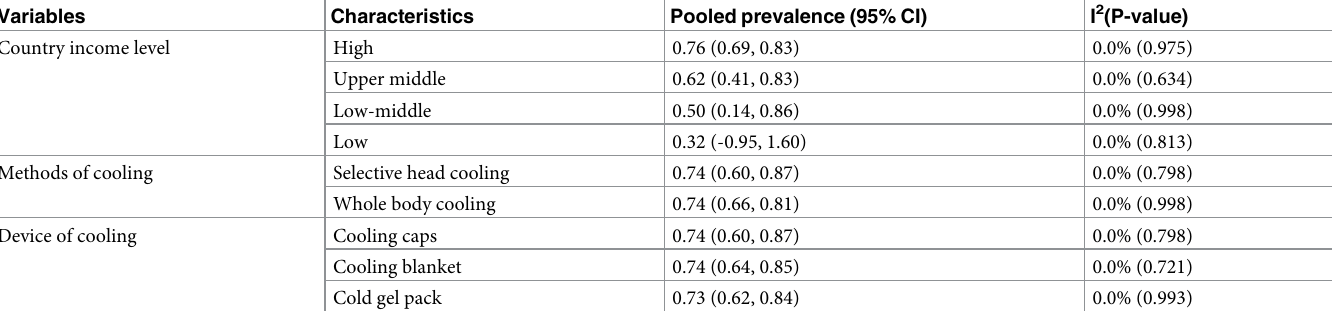
Table 5. Subgroup analysis of the effects of therapeutic hypothermia on death among asphyxiated neonates with hypoxic-ischemic encephalopathy.